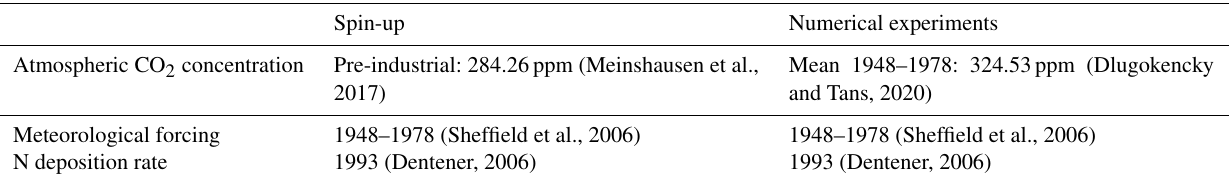
Table D3. Summary of the spin-up and numerical experiments.